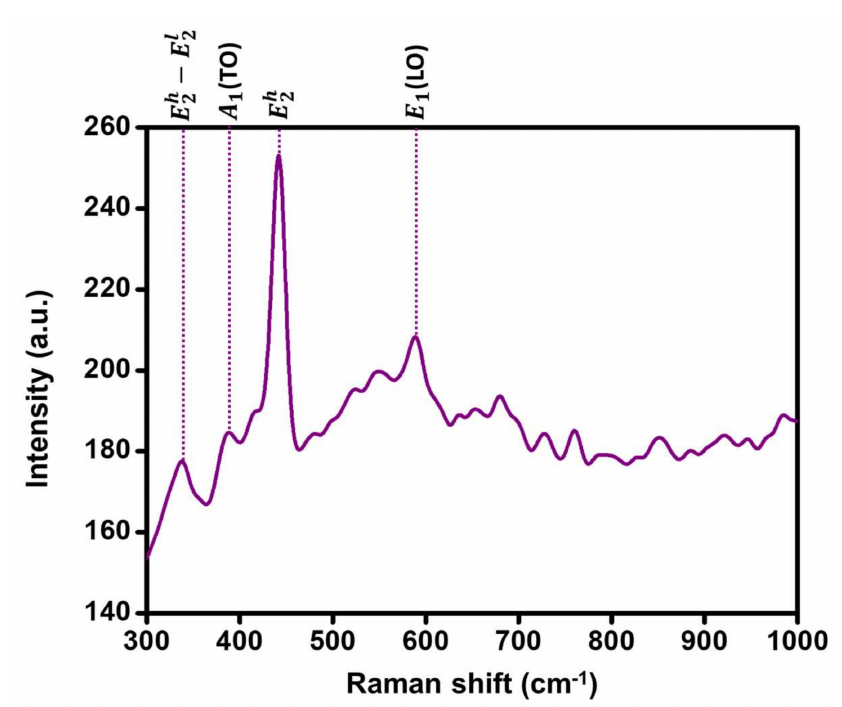
Figure 4. Raman spectrum of the as-prepared ZnO